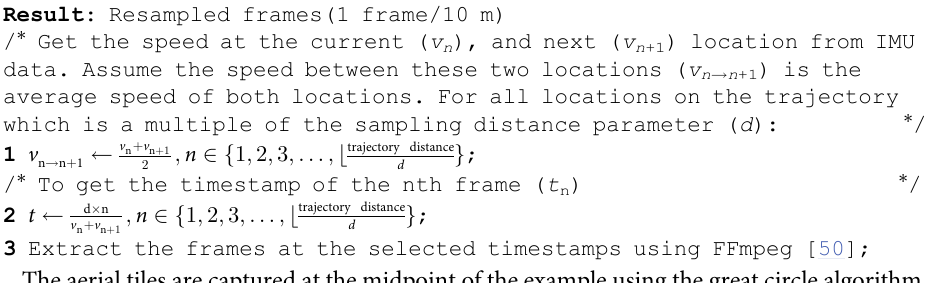
Algorithm 1 : BDD100K resampling